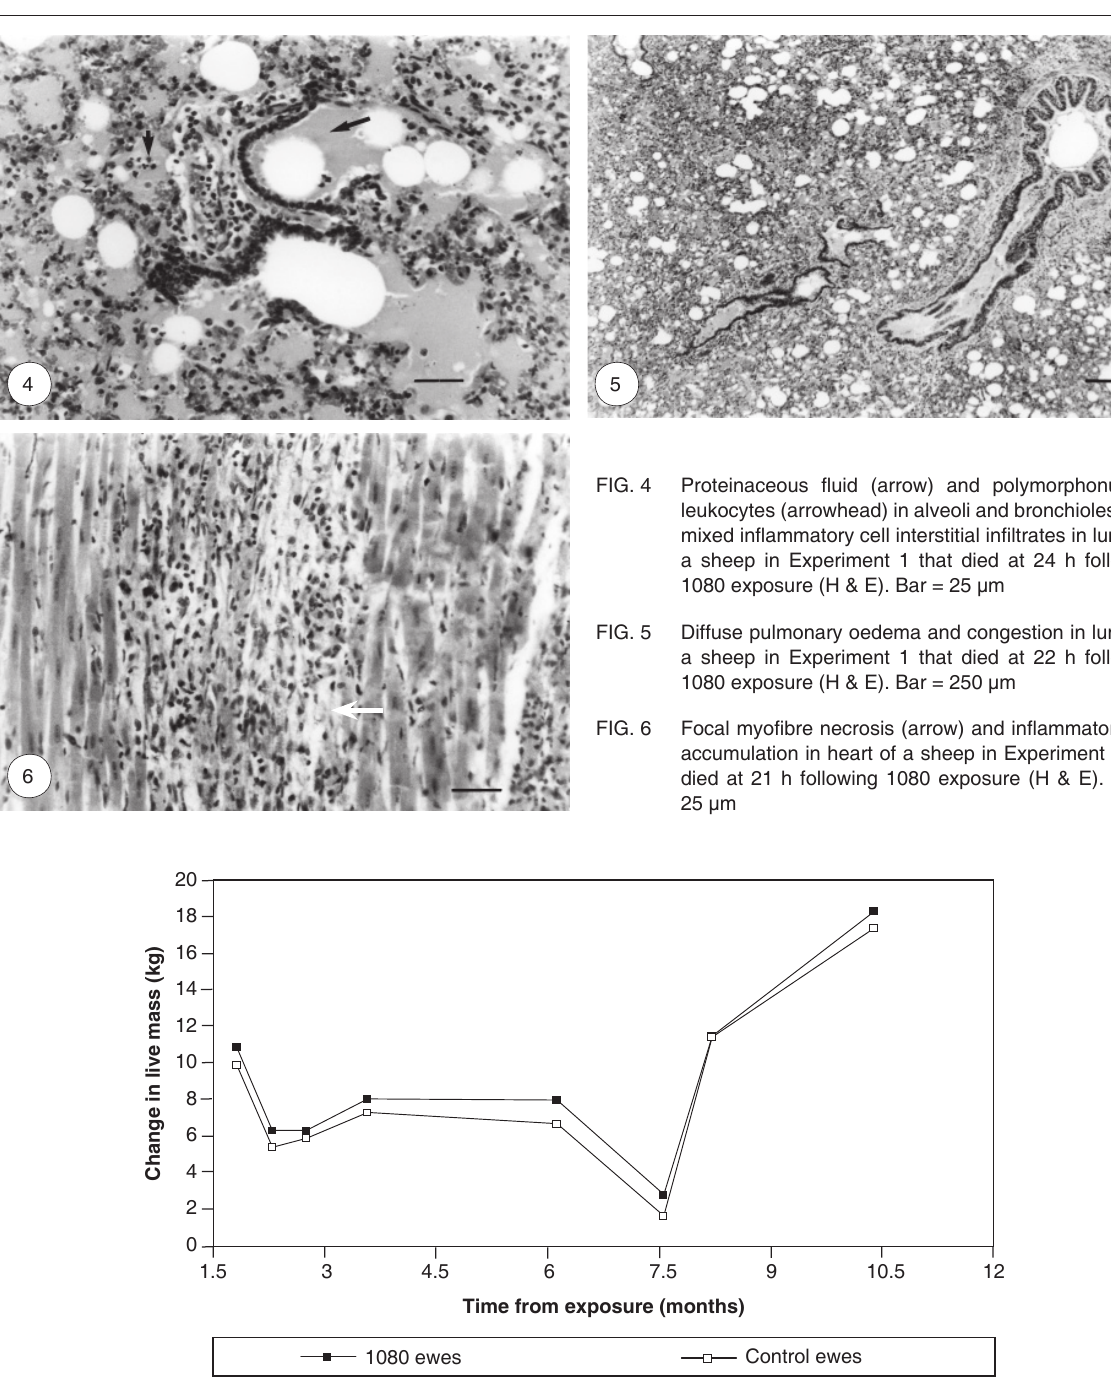
FIG. 7 Change in live mass of 21 ewes that survived exposure to sodium monofluoroacetate (1080) ( (cid:31) ) compared with that of 23 control ewes ( (cid:133) ) during the first year following dosing with 1080 (Experiment 2)